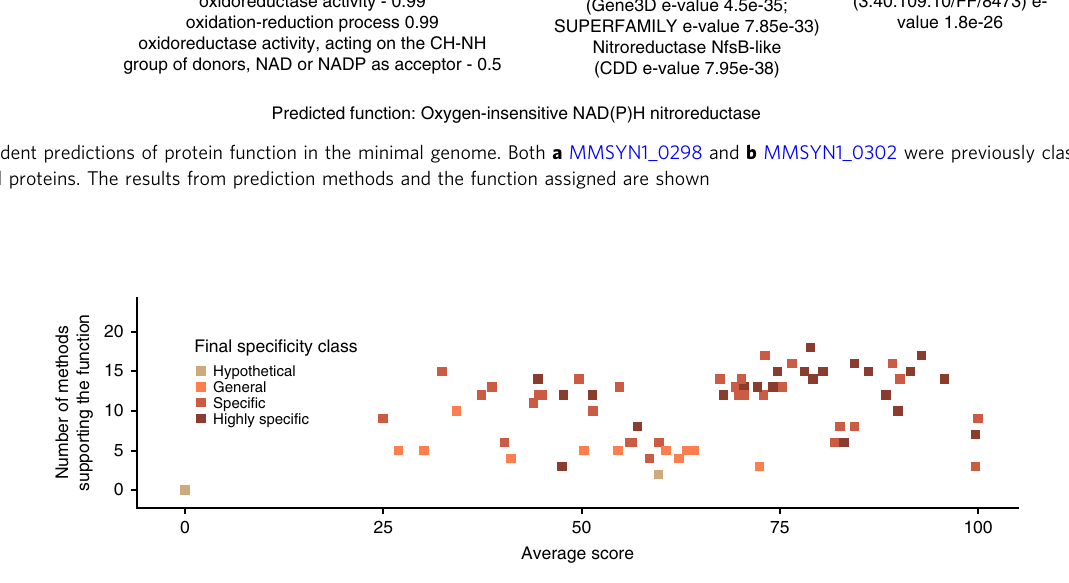
Fig. 7 Multiple methods supporting existing annotations. For all proteins where the predicted function agreed with the existing annotation (i.e., the speci fi city class was not changed), the number of methods that predicted the function is plotted against the average score from these methods. Points for each of the fi nal speci fi city classes are represented by a different colour: beige for the Hypothetical speci fi city class, orange – General, light brown – Speci fi c and dark brown – Highly speci fi